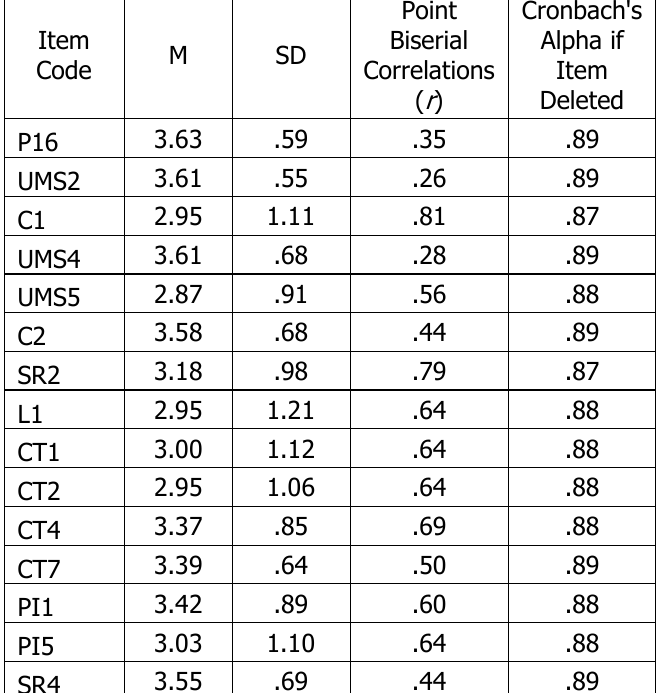
The Item Total Statistics for Form A